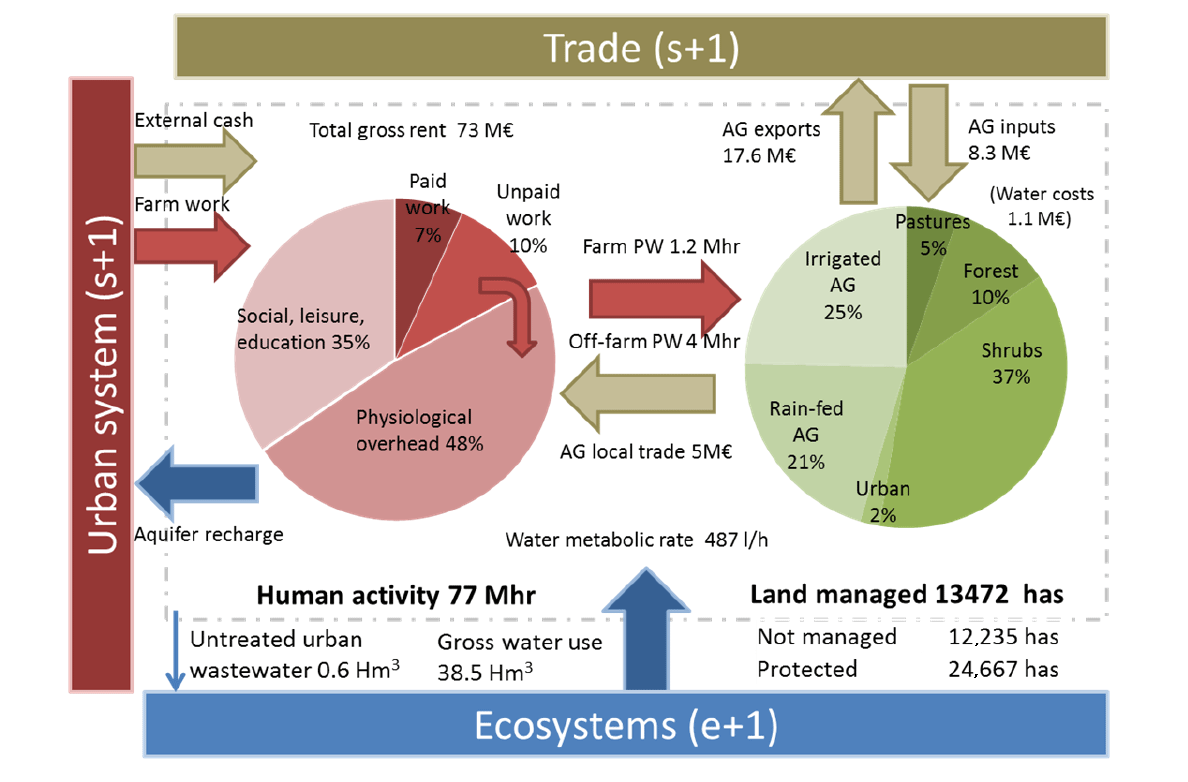
Fig. 7 . Annual societal funds and interactions with main contexts. AG: agriculture; PW: paid work; M: millions; Mhr: million hours.